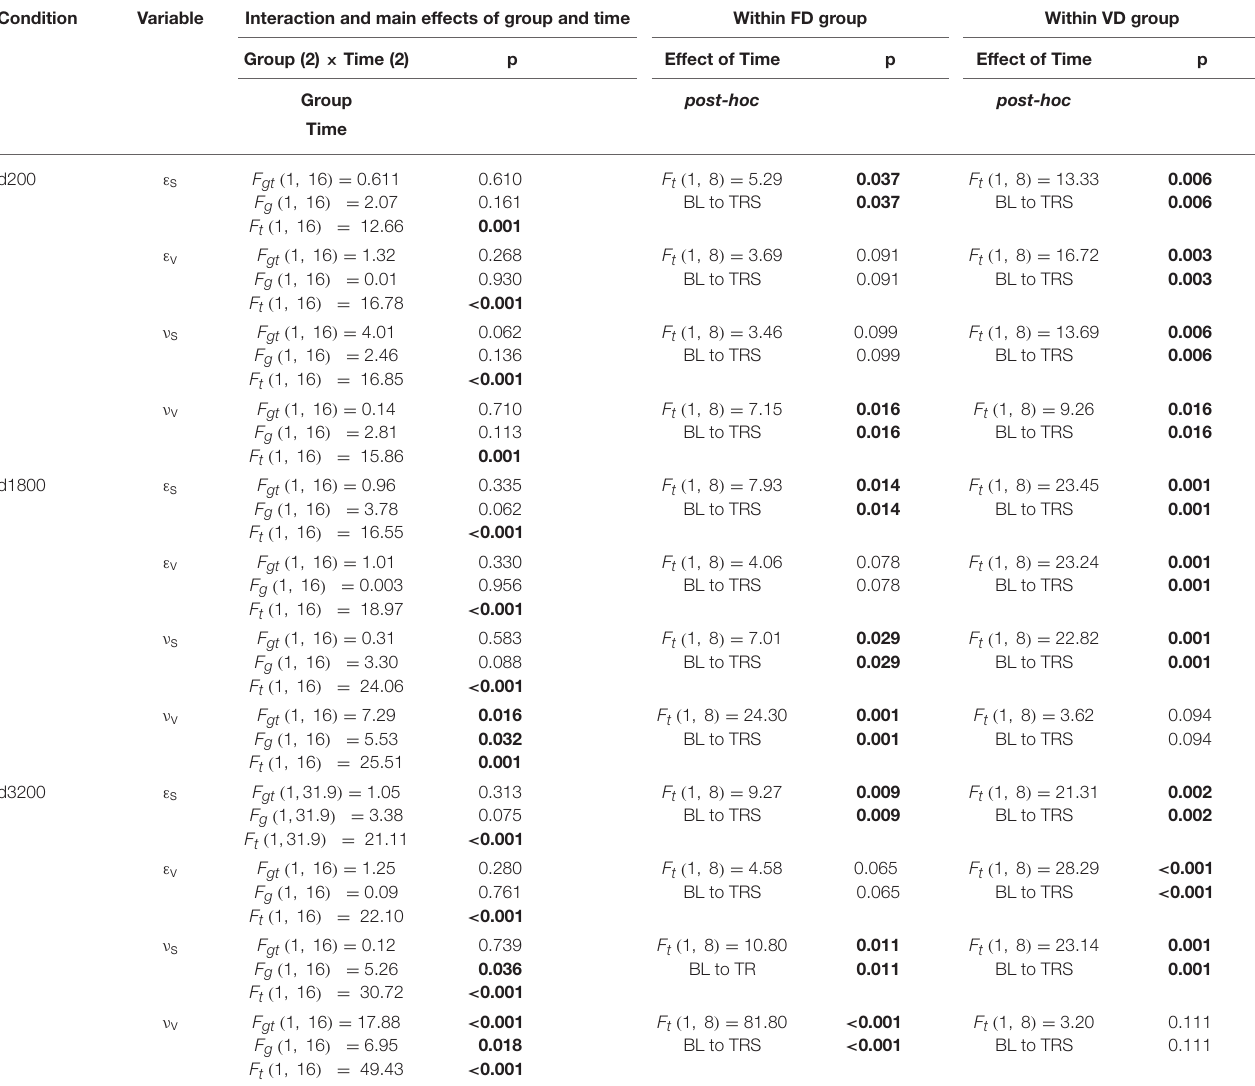
TABLE 3 | Group × Time interaction, main effects of Group (VD, FD) and Time (BL-d200 to TRS-d200; BL-d1800 to TRS-d1800, BL-d3200 to TRS-d3200) are shown on the left column for each density condition.